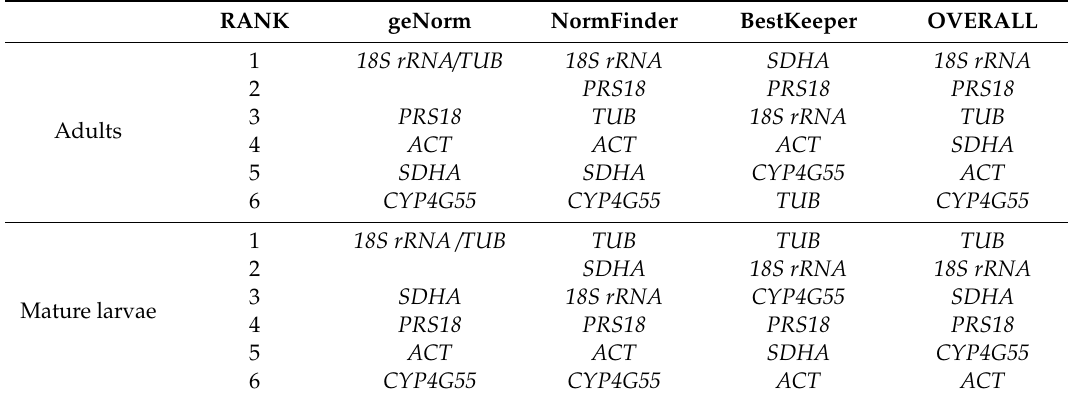
Figure 5. Relative expression levels of HSP21 under various temperatures in adult D. valens using different reference genes. ( A – C ) 18S rRNA , RPS18 and CYP4G55 were used as reference genes, respectively ． Data are mean ± SE. Different letters above bars mean significant differences ( p < 0.05, Duncan’s test). 4. Discussion Our results showed that 18S rRNA and TUB were stable reference genes in adults and mature larvae at different temperatures, respectively. 18S rRNA is a commonly used reference gene. In Coccinella septempunctata , 18S rRNA is considered the best reference gene for analyses of gene expression in different tissue types; in H. axyridis , it is considered the best reference gene for analyses of gene expression at different temperatures [17,21]. Tubulin is a cytoskeleton component. It functions in the maintenance cell shape, mitosis, cell movement, intracellular transport, and organelle composition. Genes encoding tubulin are often used as reference genes. TUB is expressed stably in various tissues of D. virgifera virgifera [15]. It is also stably expressed under different temperature treatments in Nilaparvata lugens [7], but is not stable in second-instar larvae of Galeruca daurica under different temperature treatments [22]. Few studies have focused on reference genes in D. valens . Cano-Ramirez preliminarily screened reference genes and found that CYP4G55 is stable and could be used as a reference for studies of P450 in the antennae and intestines of D. valens exposed to monoterpenes [18]. However, in this study, CYP4G55 stability was low relative to those of the other candidates in both adults and mature larvae in low temperatures. Actin (ACT) is the main structural protein of the cytoskeleton with an important role in cell functions. However, we found that this gene, which is commonly used as a reference in other insects, is far less stable than other candidate reference genes in adults and mature larvae. Similarly, in different tissues of C. septempunctata and at different temperatures in Phenacoccus solenopsis , Henosepilachna vigintioctomaculata , and Hippodamia convergens , ACT has low stability [21,23– 25]. It is a relatively stable reference gene in Myzus persicae under temperature stress [26]. These